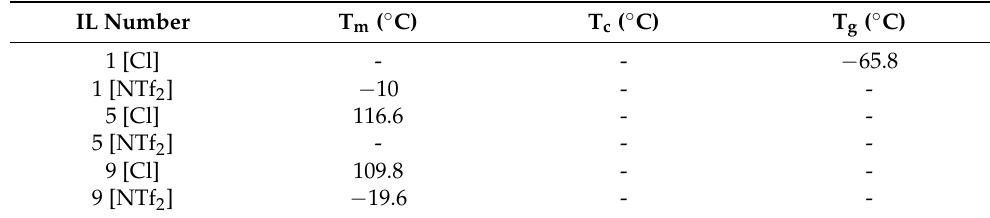
Table 2. Thermal transitions for chlorides and bis(trifluoromethanesulfonyl)amides of three examined cation groups.